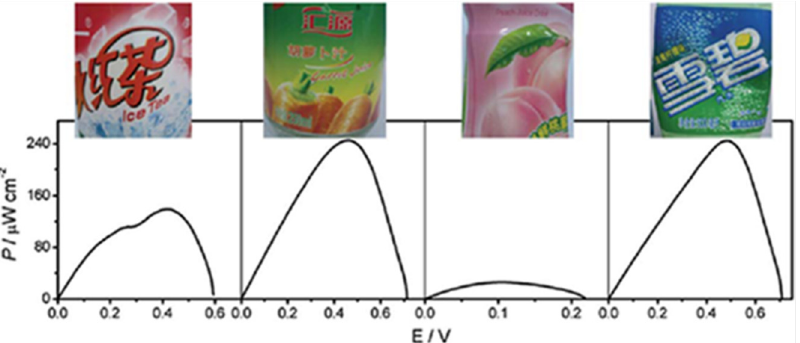
Figure 6. The power outputs of the glucose/air BFC harvesting energy from different kinds of soft drinks (from left to right: iced red tea, vegetable juice, fruit juice, and aerated water). Reproduced with permission of [54]; Royal Society of Chemistry,